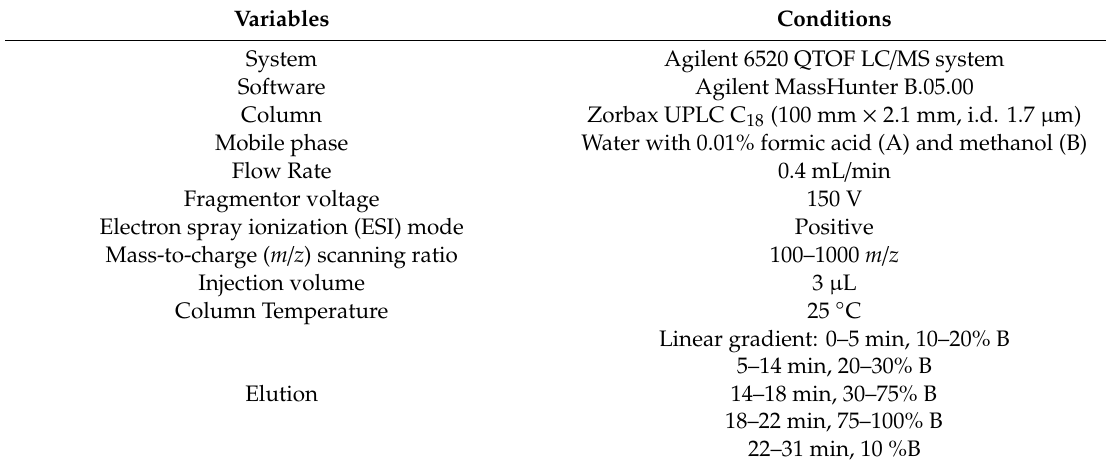
Table 7. Optimized UHPLC-QTOF condition for identification of phytoconstituents present in R. serpentina extract.